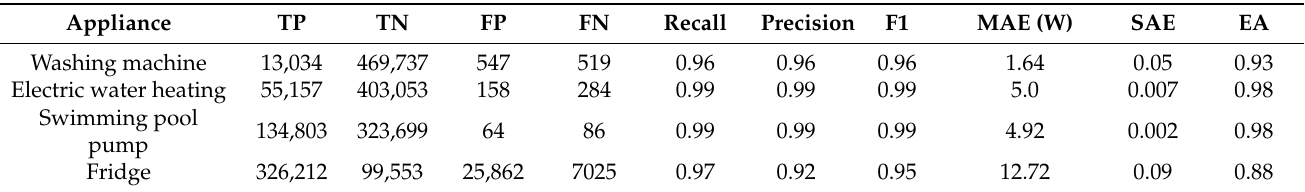
Table 6. Performance’s evaluation results with ApproxHull: mean absolute error (MAE), signal aggregate error (SAE), and estimation accuracy